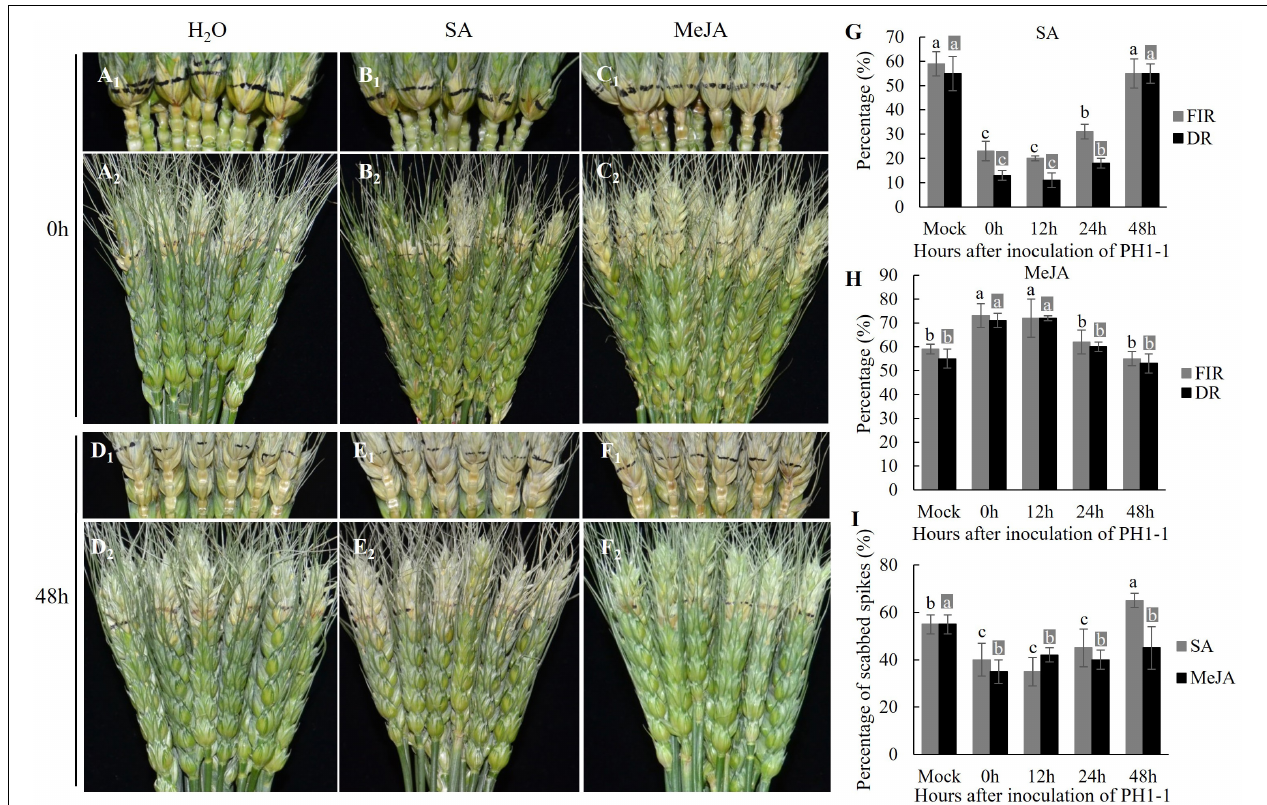
FIGURE 4 | The comparisons of FHB symptoms, first infected rachises (FIR), and dead rachises (DR) on the spikes of Jimai 22 that were applied with exogenous SA and MeJA at 0–48 h after inoculation (HAI) with PH1-1. (A 1 –F 1 ) Showed the infected rachises of the inoculated spikes at 7 days after inoculation (DAI) and (A 2 –F 2 ) showed the infected spikelets in inoculated spikes at 7 DAI. All these samples were treated with H 2 O (Mock), SA, and MeJA, respectively. (G,H) Percentage of FIR and DR in the infected spikes of Jimai 22 that were applied with H 2 O, SA, and MeJA at 0 h, 12 h, 24 h, and 48 h after PH1-1 inoculation at 4 DAI and 7 DAI, respectively. (I) PSS of infected spikes of Jimai 22 at 15 DAI that was applied with H 2 O, SA, and MeJA at 0, 12, 24, and 48 HAI of PH1-1. Error bar shows standard deviation. In (G–I) , different letters on the top of each bar in the same color (dark or light) indicate significant differences at p = 0.05 (LSD) among mean FIR, DR, or PSS at inoculation time points,